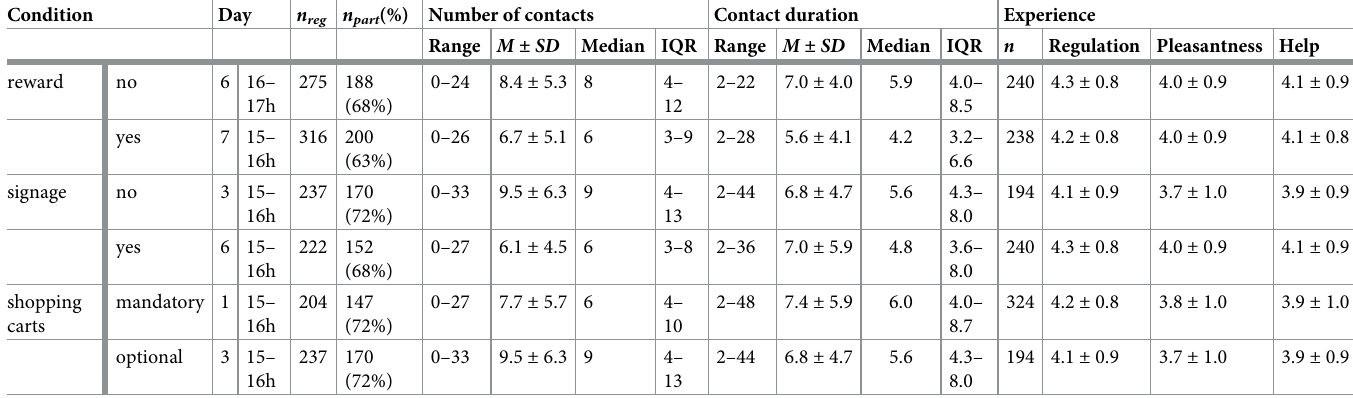
Table notes n reg indicates the number of incoming customers, as registered by the camera at the entrance, and n part indicates the number of customers who agreed to wear a tag and participate in the